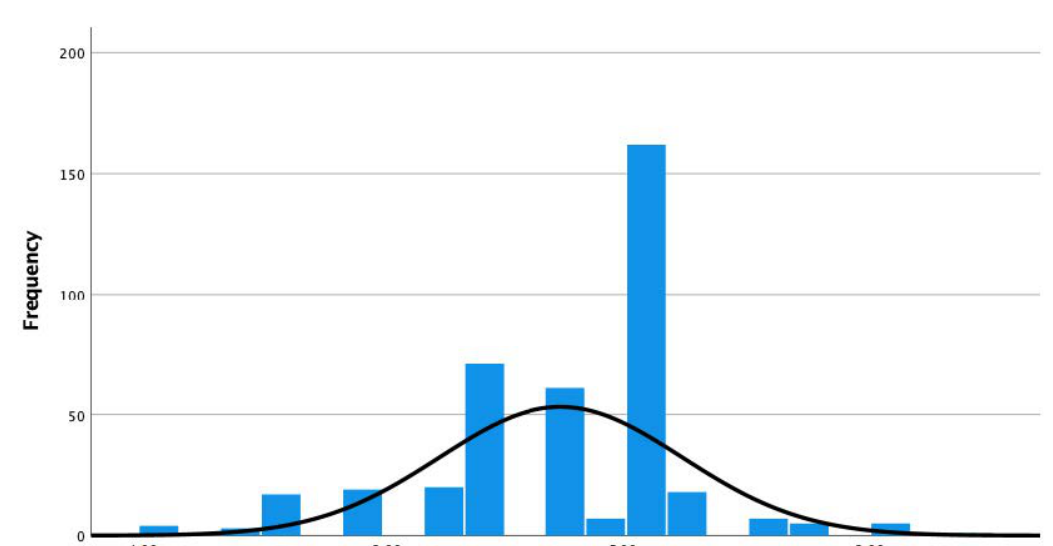
Figure 1. Histogram of the CI.